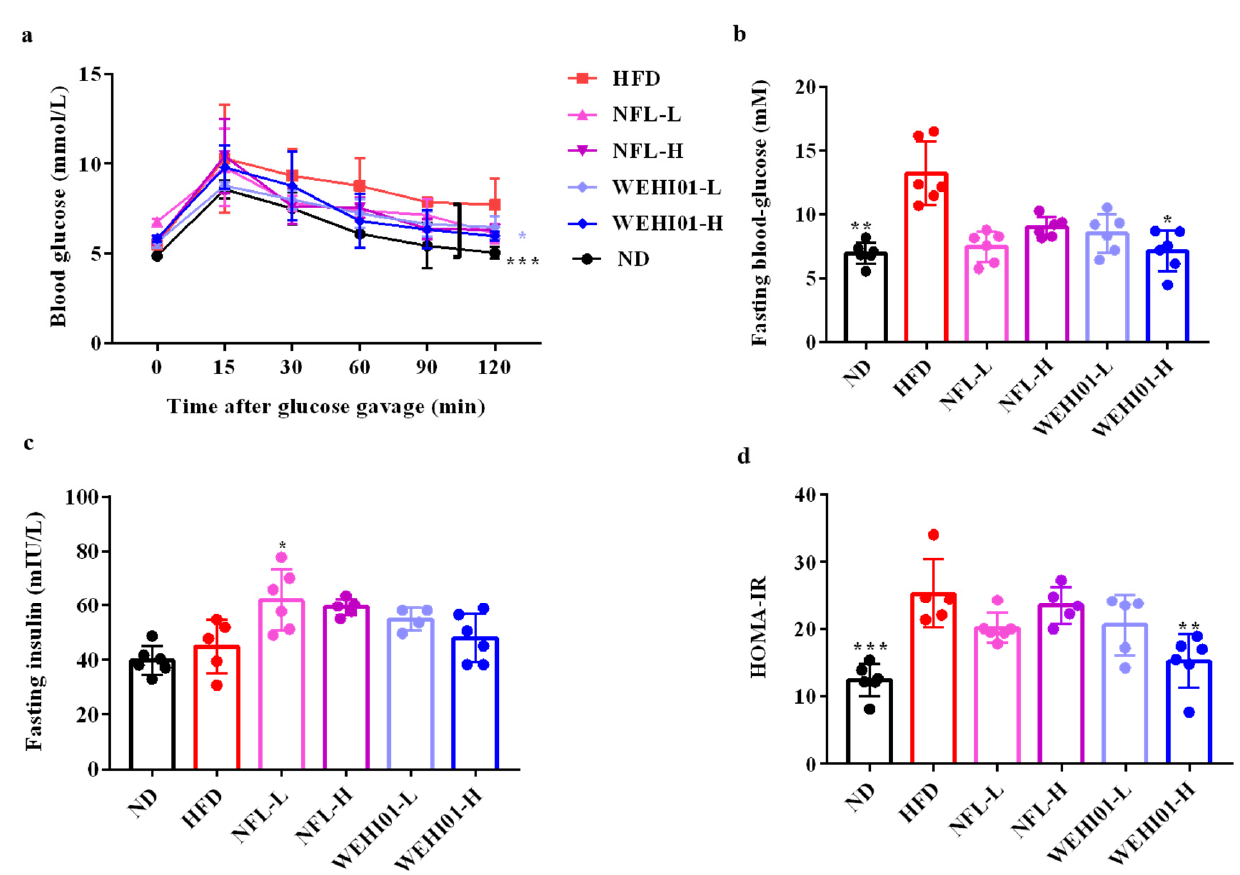
Figure 5. Effect of FLLS-WEHI01 on blood glucose levels and insulin resistance in obese rats. ( a ) Curve of the oral glucose tolerance tests. ( b ) Fasting blood-glucose. ( c ) Fasting insulin. ( d ) Homeostasis model assessment insulin resistance (HOMA-IR), calculated by fasting glucose content (mmol/L) × Fasting insulin content (mIU/L)/22.5. Values were expressed as mean ± SD ( n = 6). * p < 0.05, ** p < 0.01, and *** p < 0.001 vs. HFD group.